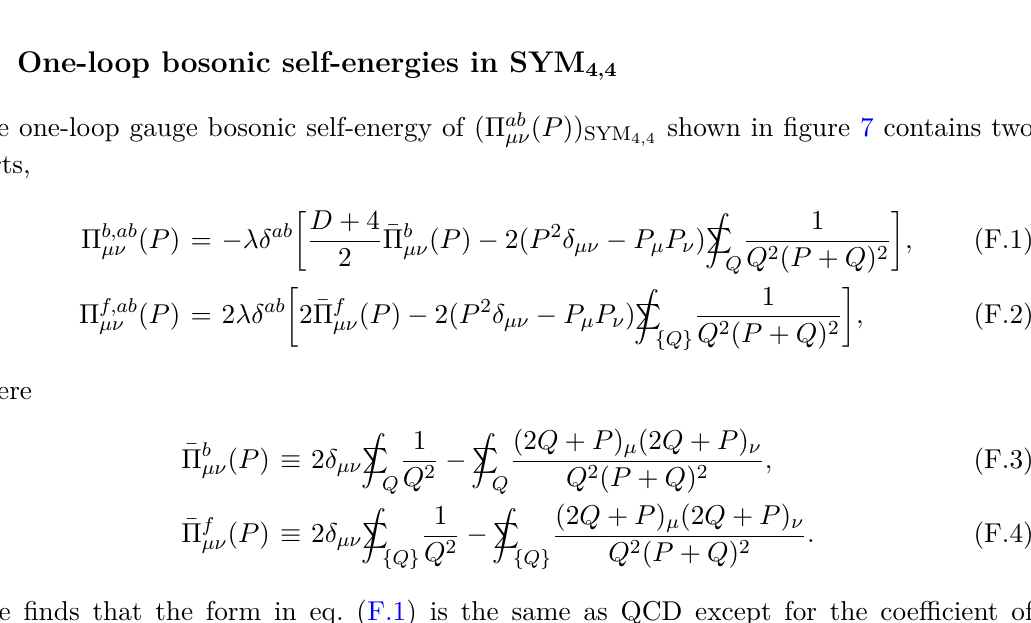
Figure 8 . The scalar self-energy in SYM 4 , 4